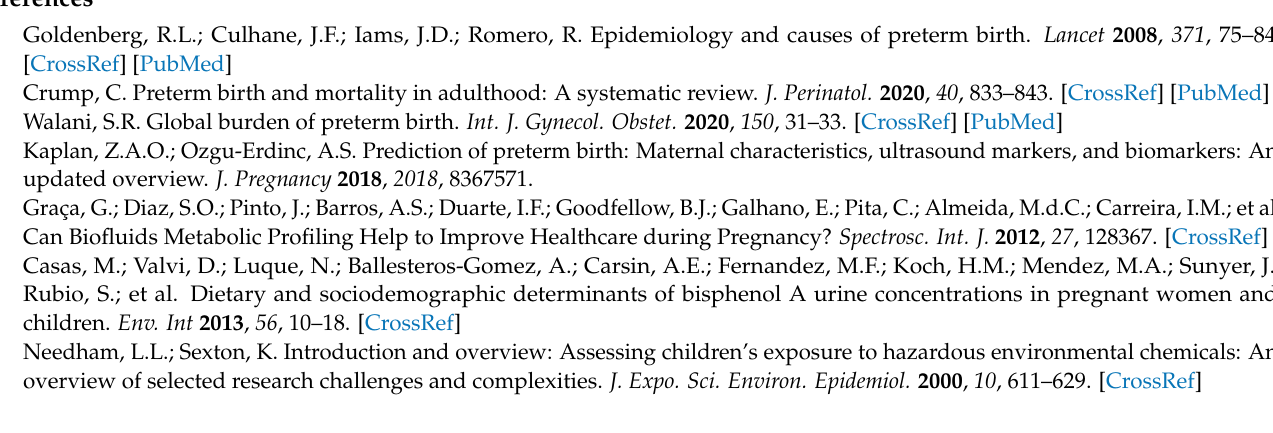
trimester, n = 10; third trimester, n = 20) and TB (second trimester, n = 10; third trimester, n = 20), Figure S2: Heats maps representing (A) PlsPCs and PlsPEs, (B) PEs, (C) Cers, (D) SMs, (E) PCs between PTB and TB., Figure S3: Log 10 peak area of lipidomes in PCs. Orange color in bar graphs and asterisk indicates PTB groups and green color indicates TB. Bar graphs are mean with * p < 0.05, ** p < 0.01, *** p < 0.001, and **** 0.0001. These are same in Figures S3–S10, Figure S4: Log 10 peak area of lipidomes in PEs, Figure S5: Log 10 peak area of lipidomes in PlsPCs, Figure S6: Log 10 peak area of lipidomes in PlsPEs, Figure S7: Log 10 peak area of lipidomes in SMs, Figure S8: Log 10 peak area of lipidomes in Cers, Figure S9: Log 10 peak area of lipidomes in TGs, Figure S10: Log 10 peak area of lipidomes in LPCs; Table S1: Descriptive characteristics among participants, Table S2: List of identified lipidomes in PCs, Table S3: List of identified lipidomes in PEs, Table S4: List of identified lipidomes in plasmenyl-PEs, Table S5: List of identified lipidomes in plasmenyl-PCs, Table S6: List of identified lipidomes in SMs, Table S7: List of identified lipidomes in Cers, Table S8: List of identified lipidomes in lyso-PCs, Table S9: List of identified lipidomes in lyso-PEs, Table S10: List of identified lipidomes in TGs, Table S11: List of identified lipidomes in